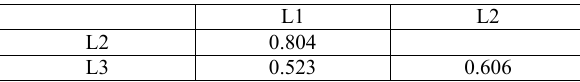
Table 1: Correlation of knowledge leadership indicators